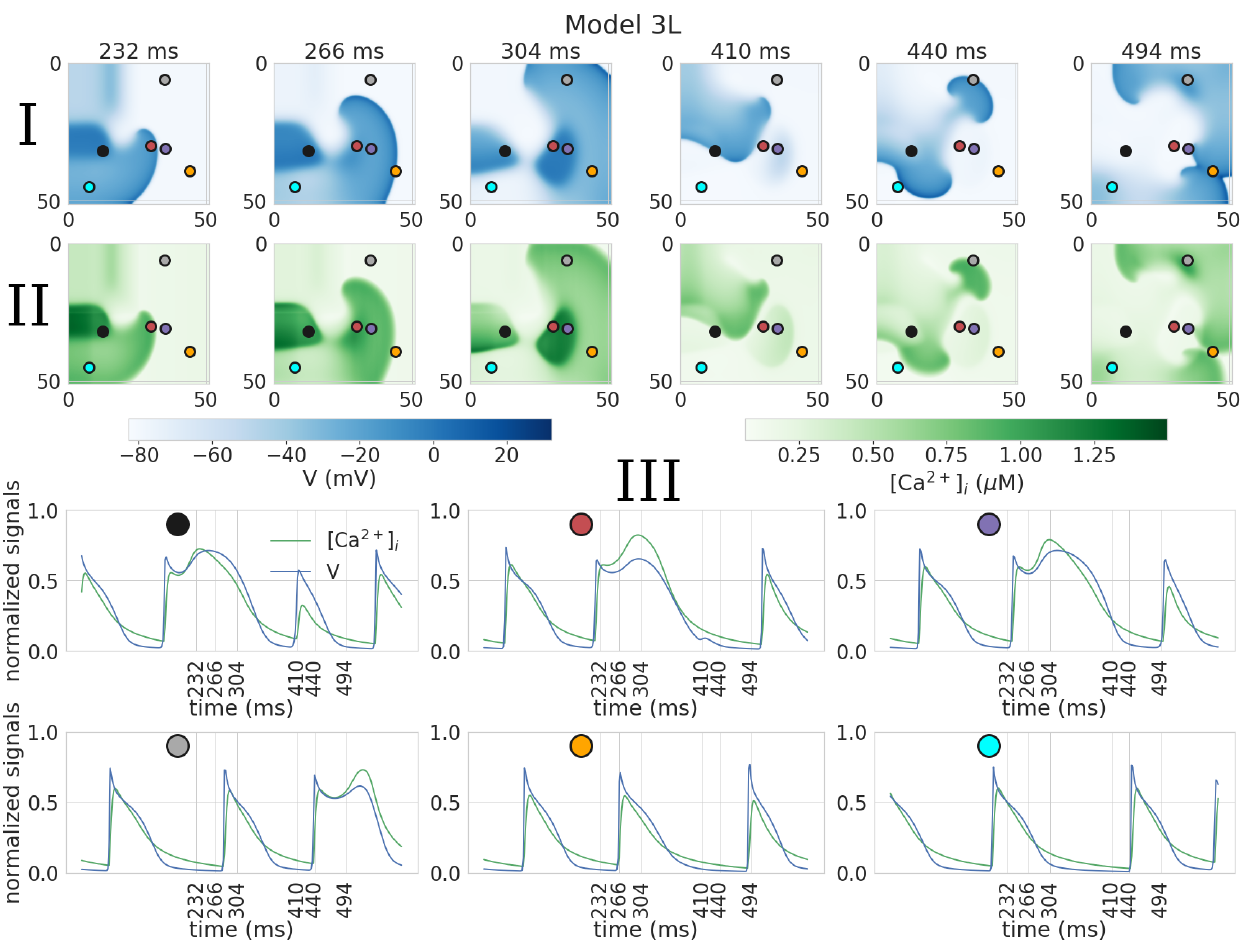
Figure 7. Breakup in 2D tissue model with cellular model 3L. Action potential (I) and calcium transient (II) maps during spiral wave rotation; III: normalized signals of the action potential and calcium transients, recorded at the points indicated on the graphs above by corresponding